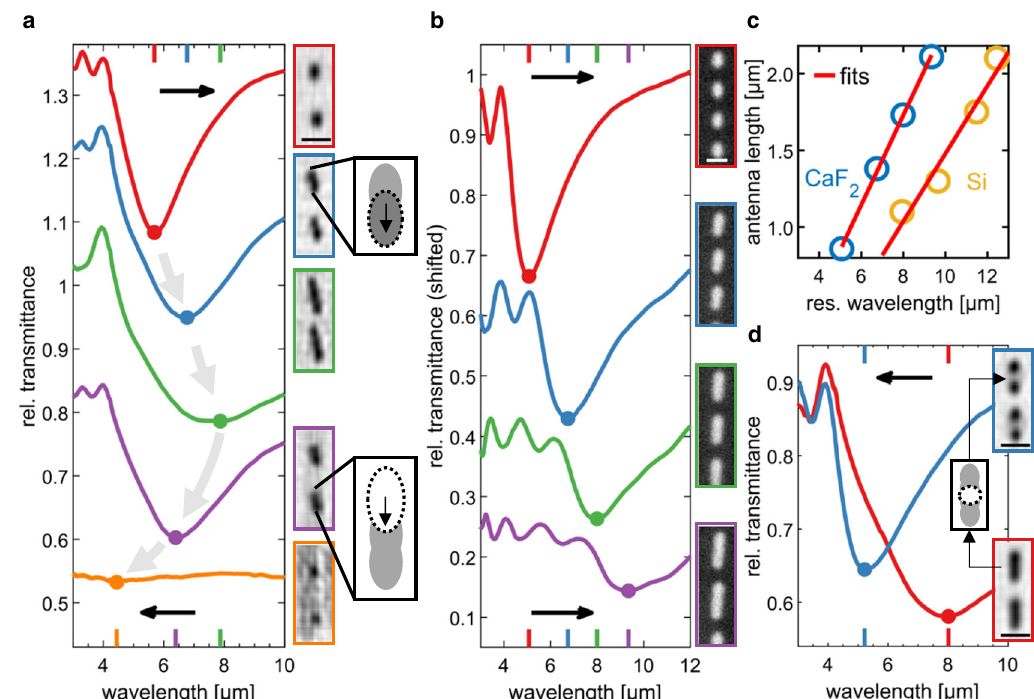
Fig. 3 Optical antenna resonance control. a Measured transmittance spectra of nanorod antenna arrays of different length (shifted on y -axis for clarity). Light micrographs (transmittance mode) are shown on the right. The length was successively increased/decreased via crystallization/reamorphization at one antenna end (see sketches). b Measured transmittance spectra of nanorod antenna arrays of different length l and adjusted period (shifted on y -axis for clarity). Light microscope images of the antennas are depicted on the right. c Plot of the antenna length l against the measured resonance wavelength. Blue data points are for antennas on a CaF 2 substrate, orange data points for antennas on a Si substrate. The red lines are linear fi ts to the two data sets and show good agreement with the data. d Measured transmittance spectra of long nanoantenna arrays (red) which were then optically cut in half (see sketch) by reamorphization (blue). Corresponding light micrographs are depicted on the right. All scale bars are 2 µ